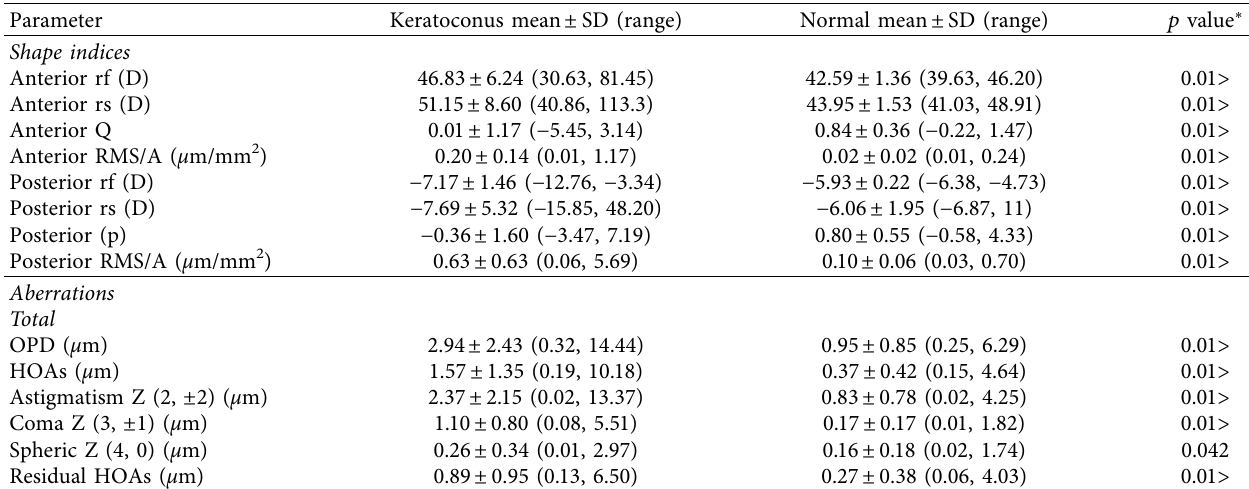
Table 2: The mean values of shape indices and aberrations in keratoconus and normal